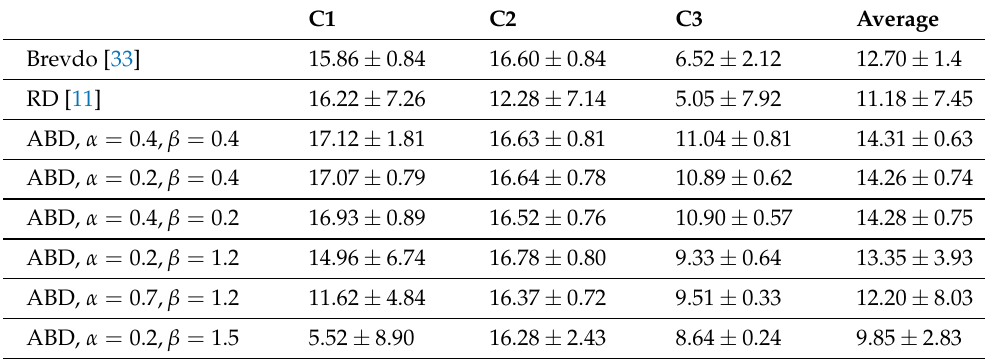
Table 2. RQF of each reconstructed components (averaged over 100 realizations of noise) for the different competing approaches for a SNR = 10 dB with AM. In second rows are displayed, for each case, the std of the